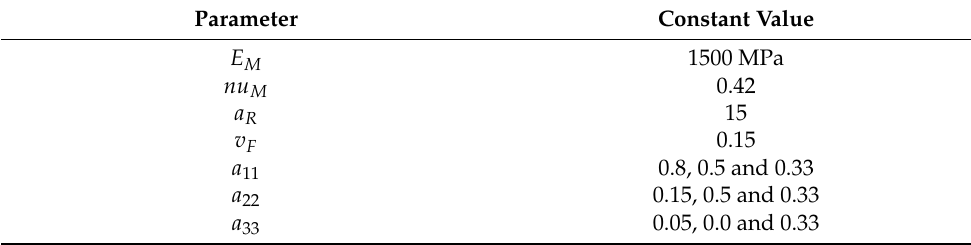
Table 2. Input parameter for the prediction.